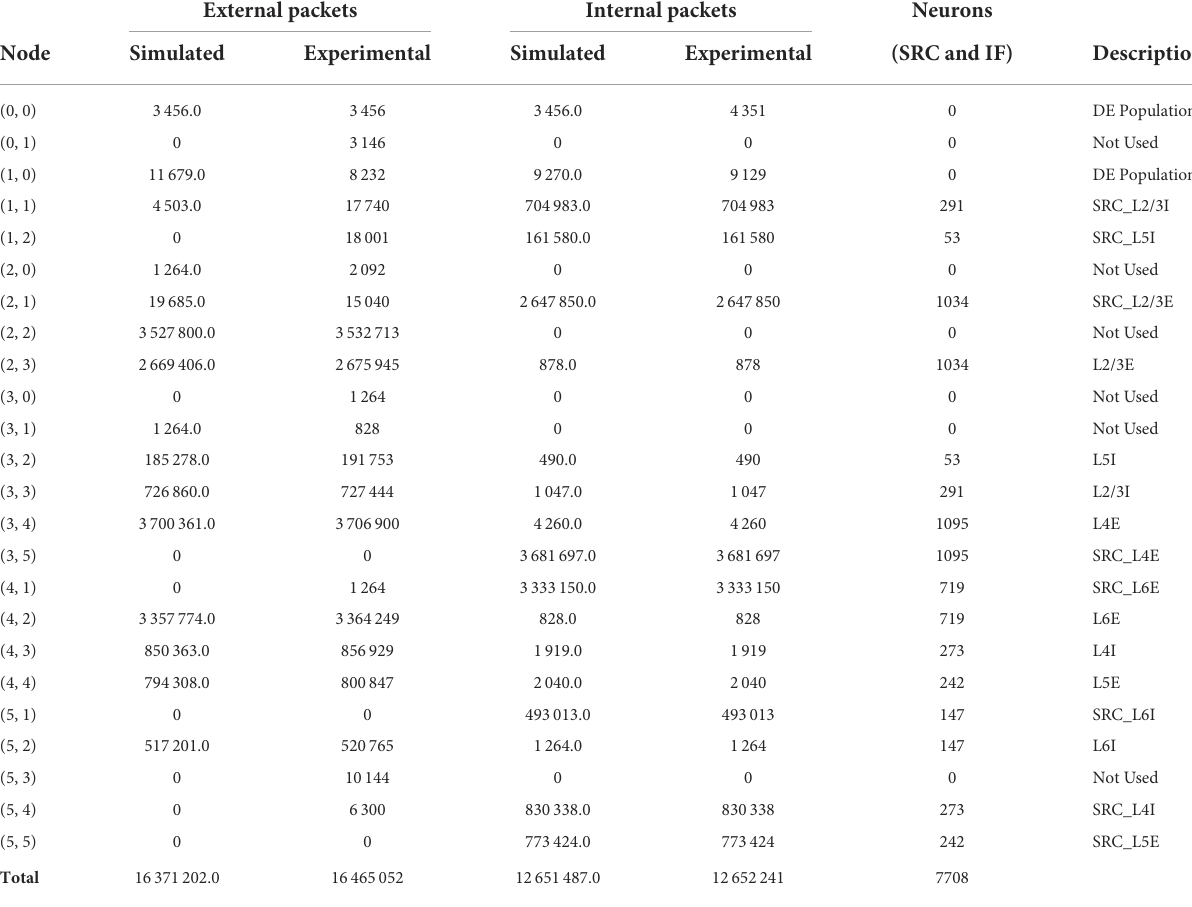
TABLE 2 Simulated communication traffic results for the test case mapped with the MANUAL procedure. External packets Internal packets Neurons Experimental (SRC and IF)